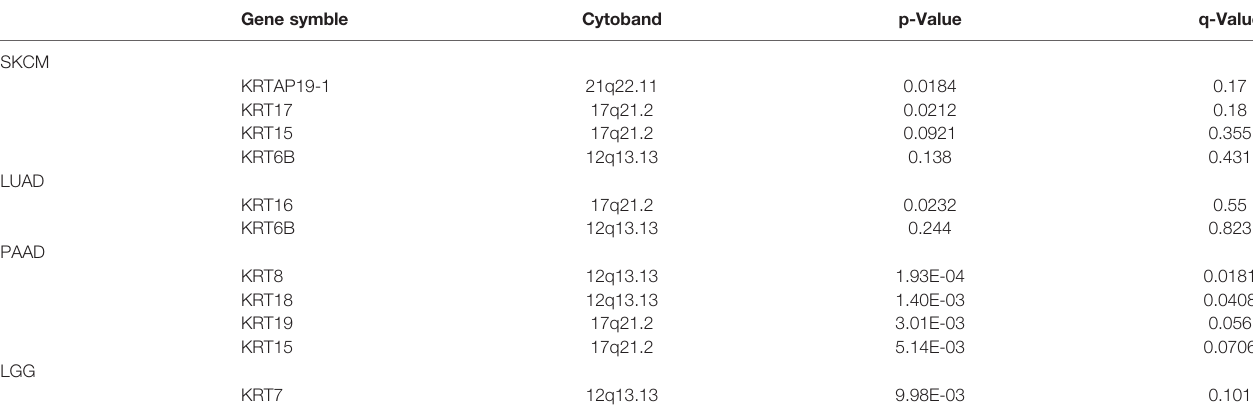
TABLE 2 | The list of lesser methylated keratin proteins.